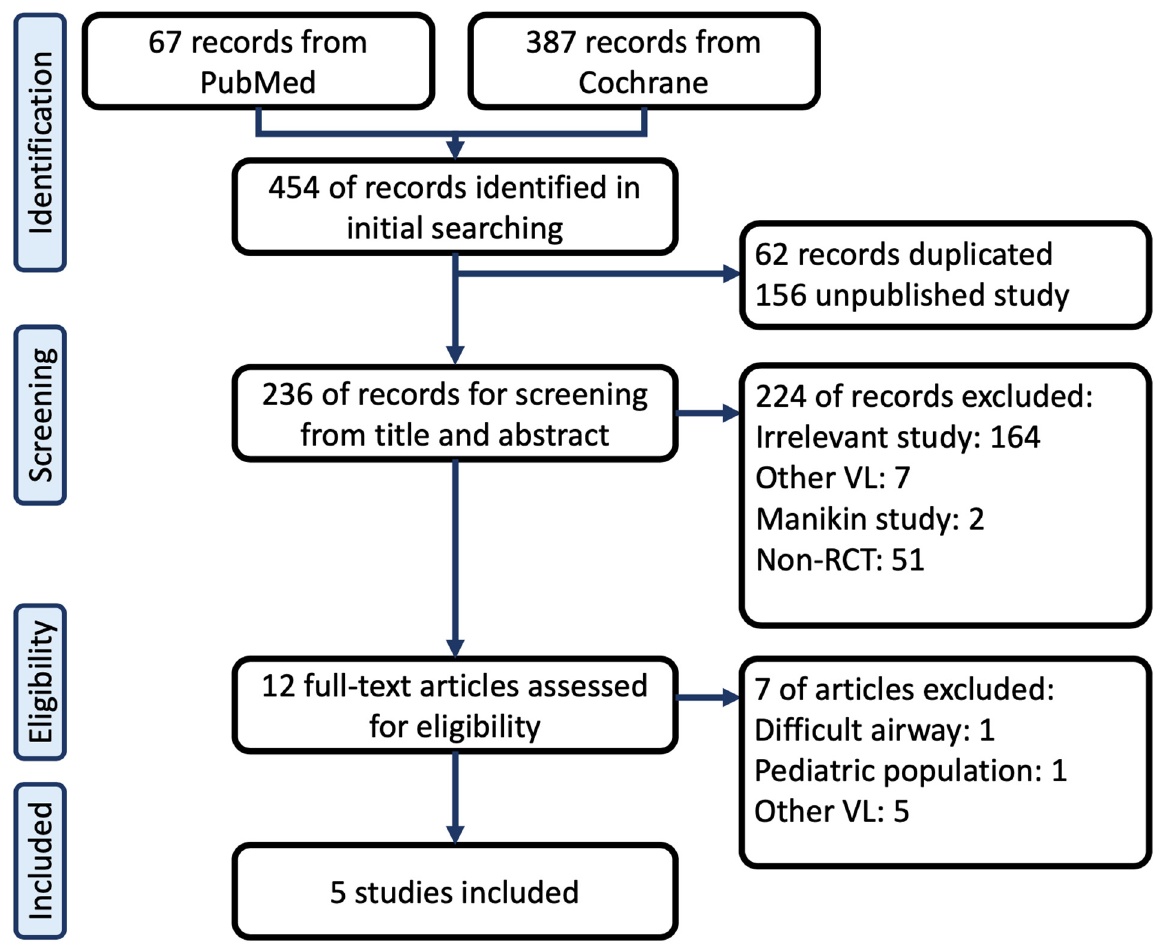
Figure 1. Flow chart of the systemic review. VL, videolaryngoscope; RCT, randomized control trial. Articles Excluded due to Difficult airway [8], Pediatric population [9], Other VL [10–14]; Included